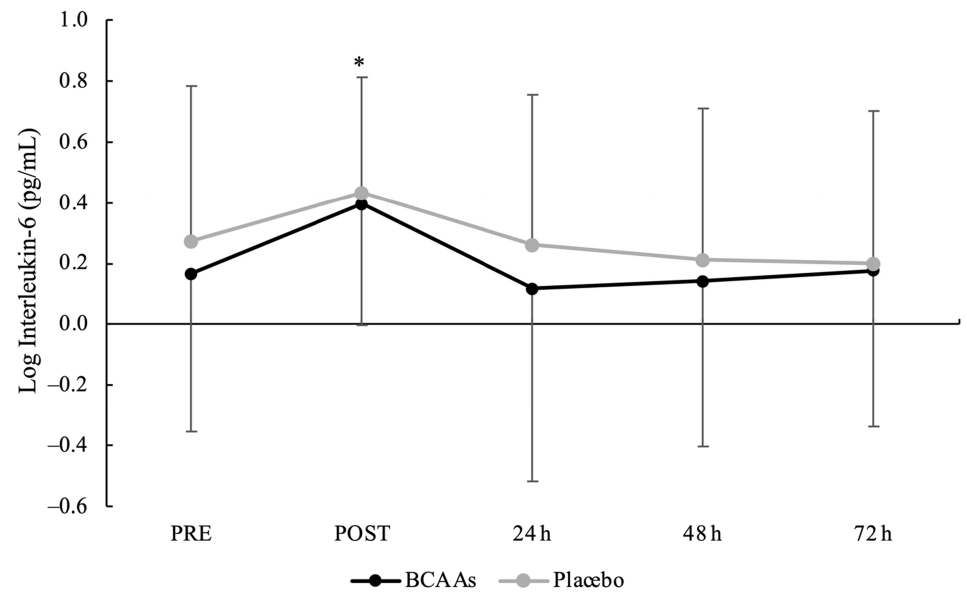
Figure 4. Interleukin-6 serum activity with logarithmic transformation during the time course of recovery. (*) Denotes differences ( p < 0.05) from all time-point measurements.